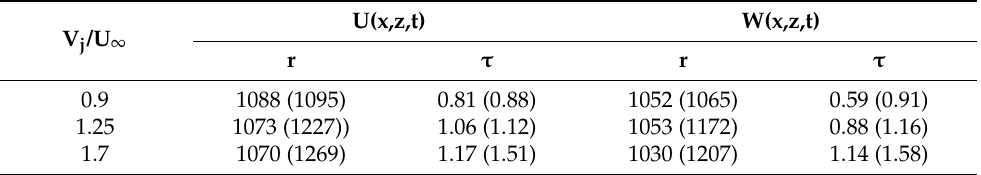
Table 2. Optimal hard truncation values for each velocity component, U and W, corresponding to each V j /U ∞ case. Measured and composite data for the tandem jets are listed with and without parenthesis,